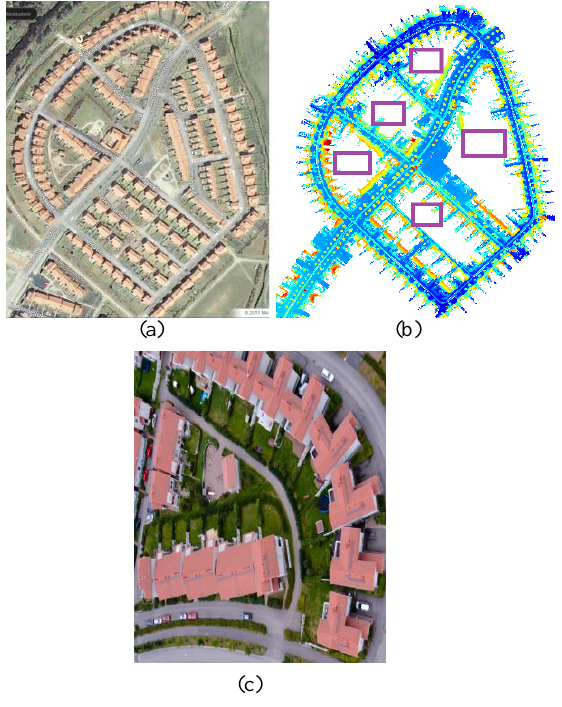
Figure 1. (a) The aerial view of a scene (from Google maps); (b) MLS data; (c) UAV image. The purple box in (b) shows